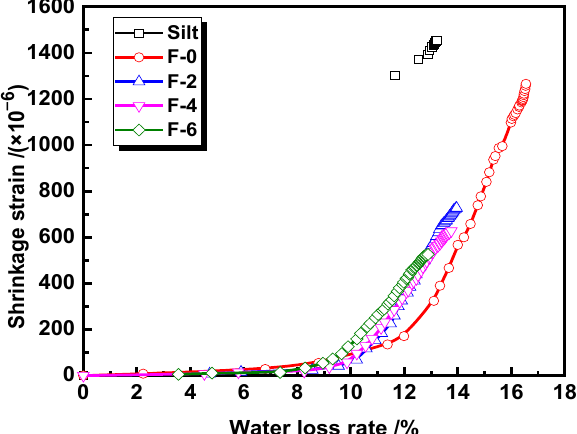
Figure 8. Variation of shrinkage coefficient with time.